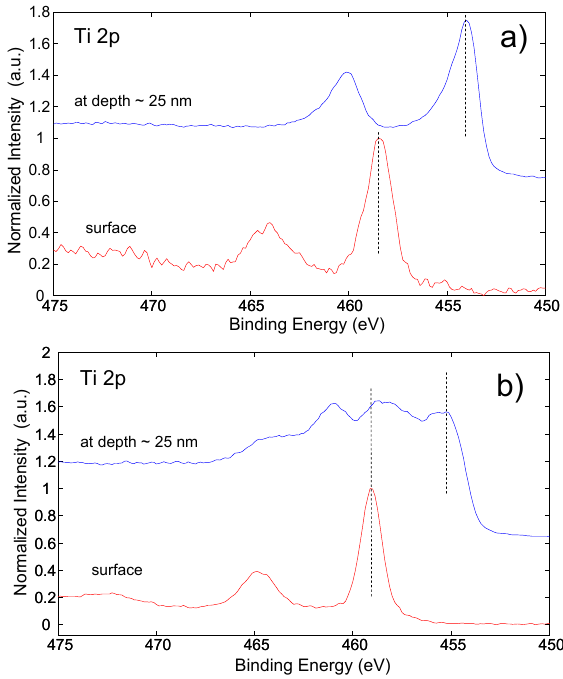
Figure 7. High energy resolution Ti 2 p spectra of ( a ) low alloyed Ti before exposure to 0.1 M NaCl solution and ( b ) laser marked Ti surface Ti-100-3 before exposure to 0.1 M NaCl solution at the surface and at a depth of 25 nm.